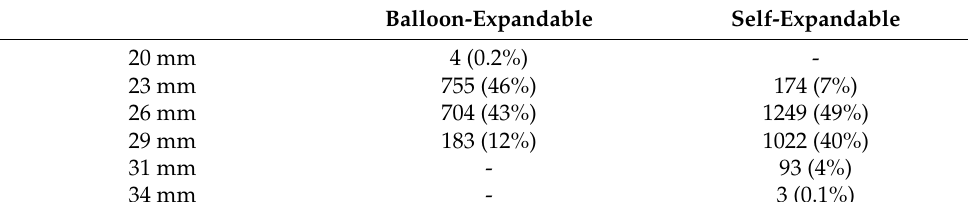
Table 2. Distribution of valve sizes in balloon-expandable and self-expandable valves.